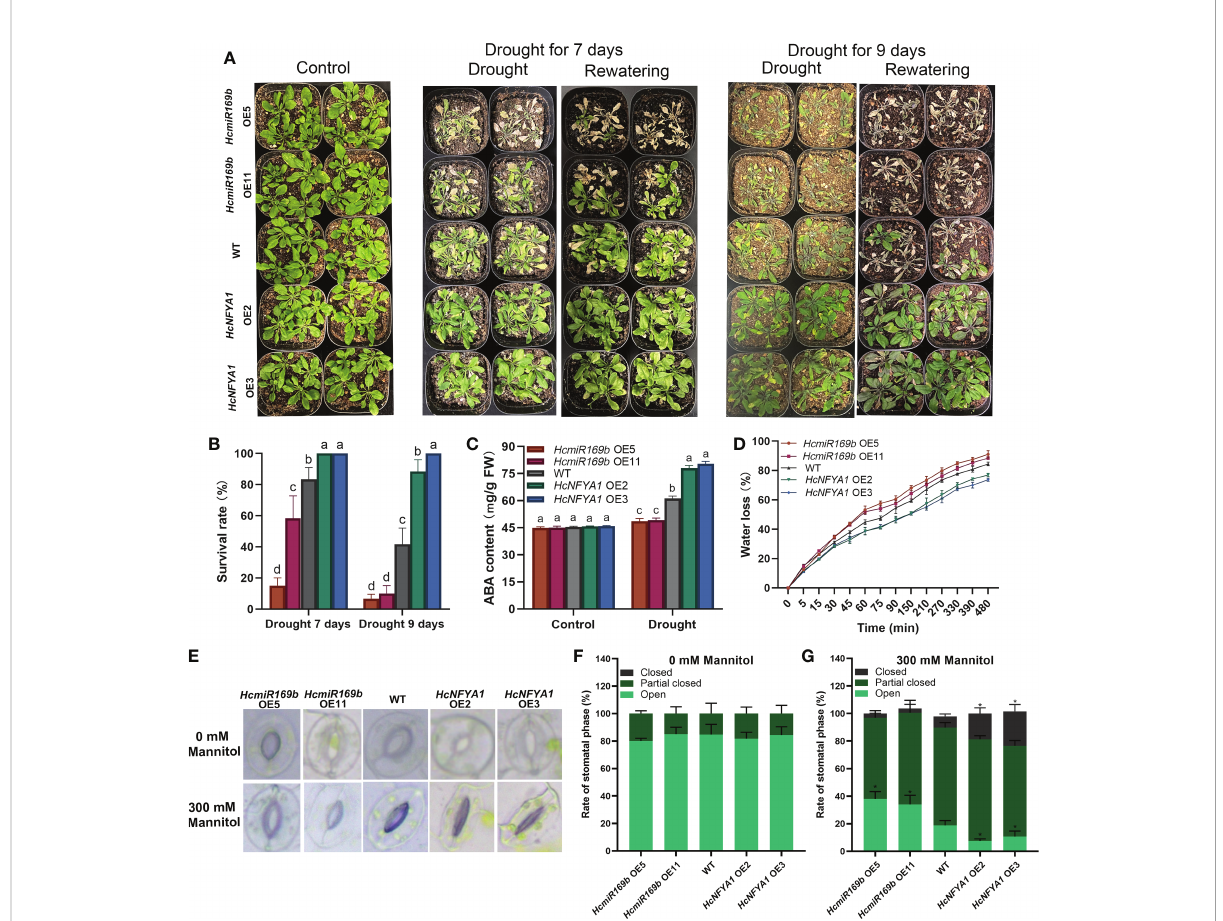
FIGURE 4 Functional analysis of Halostachys caspica miR169b/NFYA1 module under drought stress. (A, B) Phenotype (A) and survival (B) of adult Arabidopsis after 7 or 9 days of natual drought and 3 days of rewatering. (C) ABA content in Arabidopsis under control and drought stress. (D) Determination of water loss in detached leaves of Arabidopsis . (E-G) Stomatal apertures of Arabidopsis leaves under 0 and 300 mM mannitol (simulated drought) treatment were photographed (E) and the percentage of various stomata (F, G) . Data were shown as the means ± SD of three independent experiments. Different letters indicated signi fi cant differences in survival rate and ABA content of each type of Arabidopsis between treatments (Duncan ’ s multiple range test, p <0.05), asterisk indicated a signi fi cant difference in the percentage of this stomatal type compared to WT (Student ’ s t-test, * p